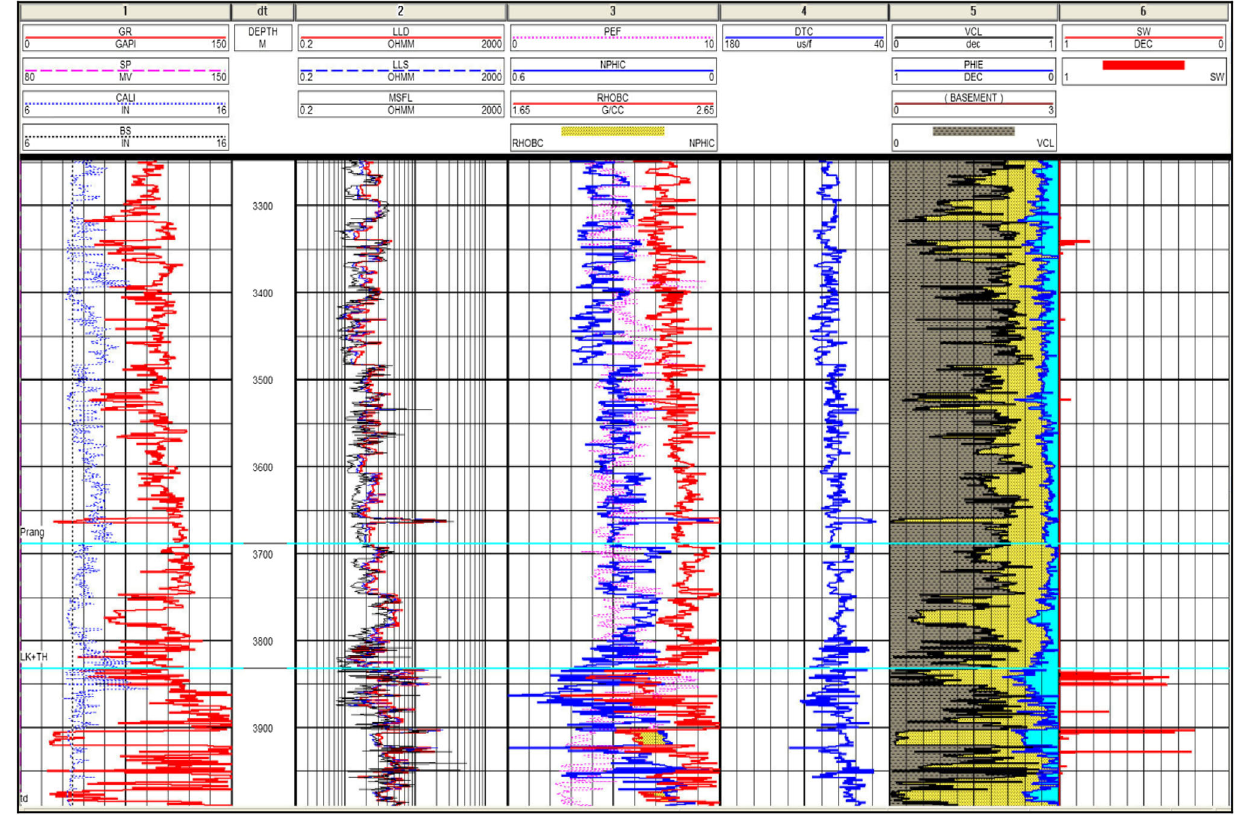
Fig. 16 Petrophysical results of one representative well-A